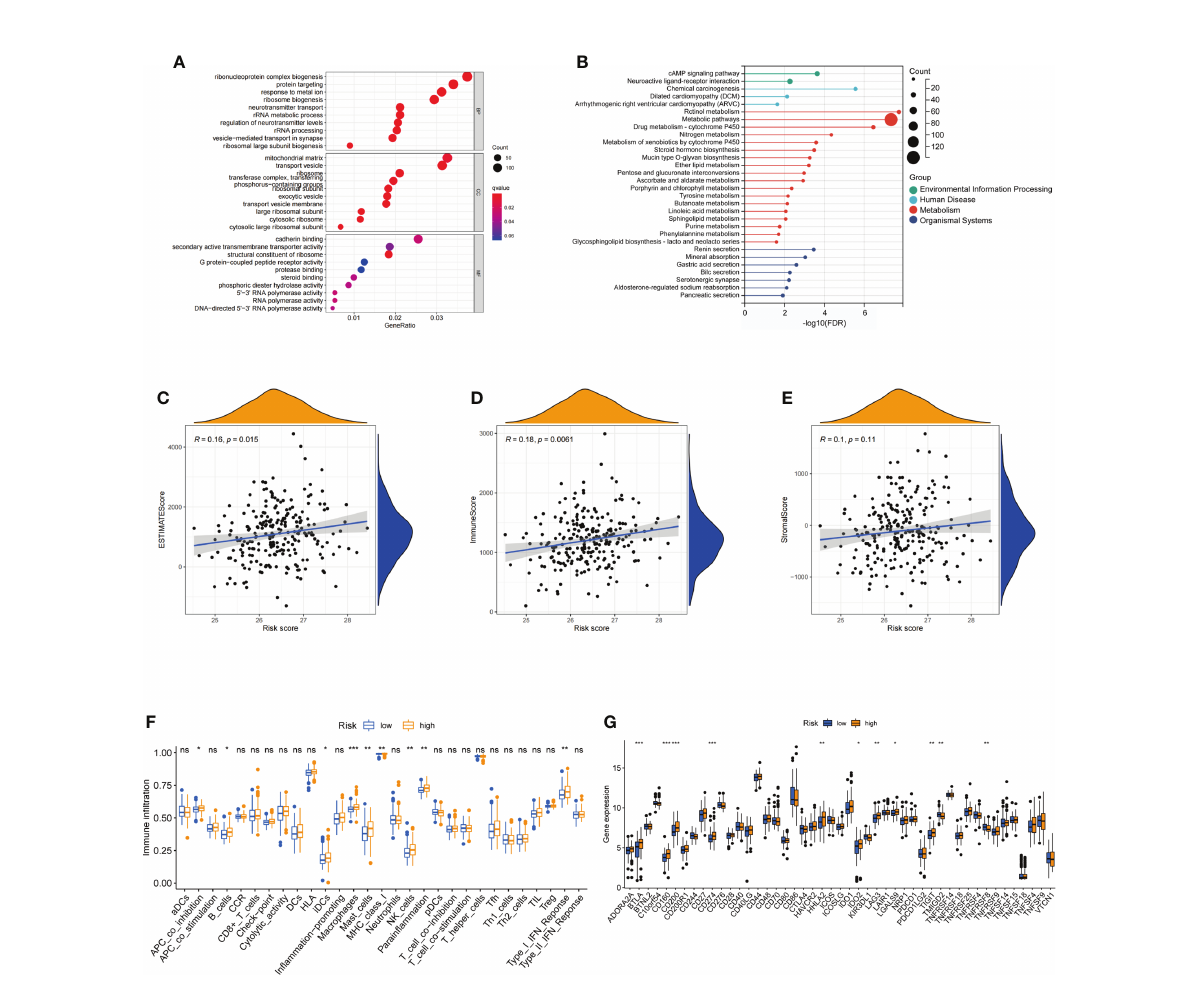
FIGURE 6 Functional analysis of differentially expressed genes and the immune landscape of fatty acid metabolism-related signatures. (A, B) The enriched GO and KEGG terms based on DEGs between low-risk and high-risk groups. (C – E) Correlation between estimate scores, immune scores, stromal scores, and risk scores. (F) The expression of immune checkpoints in low-risk and high-risk groups. (G) The ssGSEA score of immune cells and immune-related functions with low-risk and high-risk groups. GO, gene ontology; KEGG, Kyoto Encyclopedia of Genes and Genomes; DEGs, differentially expressed genes. ns: not signi fi cant; *: P< 0.05; **: P< 0.01; ***: P<